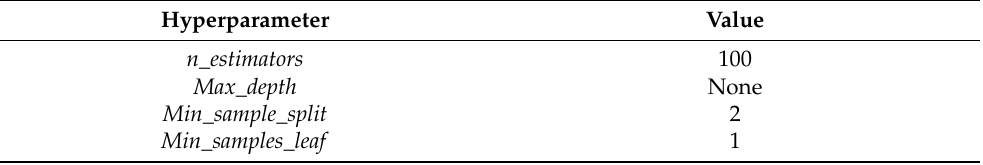
Table 4. Hyperparameters of the random forest (RF)